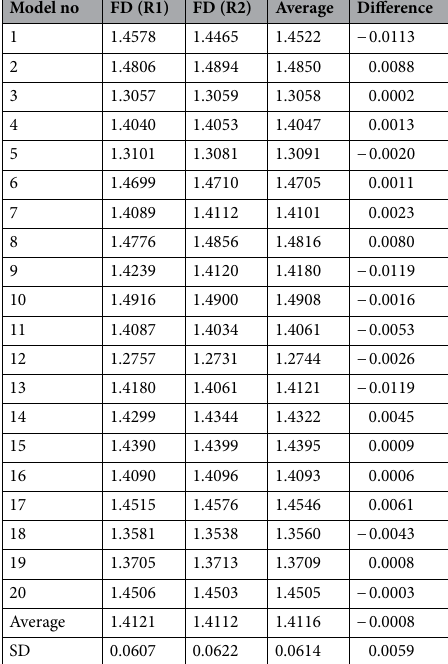
Table 1. Fractal dimensions (FD), as measured by rater 1 (R1) and rater 2 (R2) (inter-rater